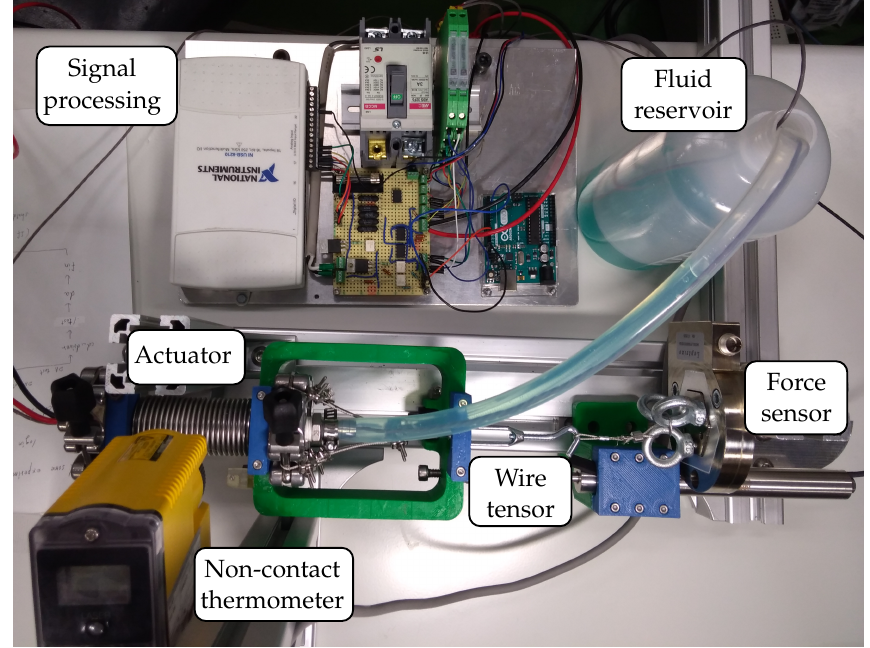
Figure 7. Zero-Flow